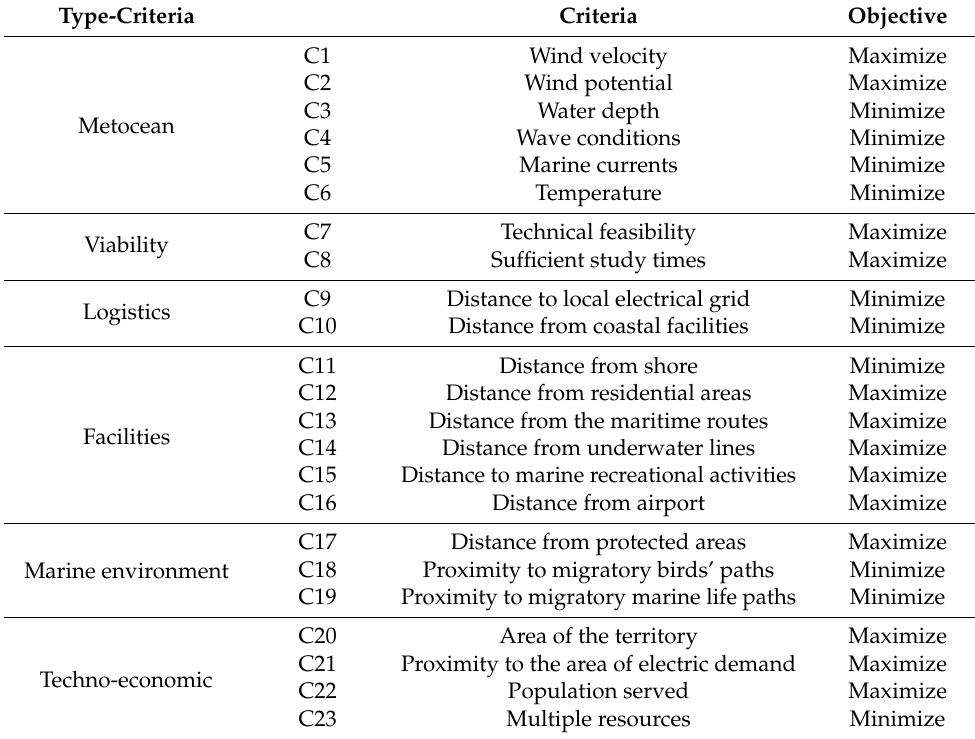
Table 2. Evaluation criteria